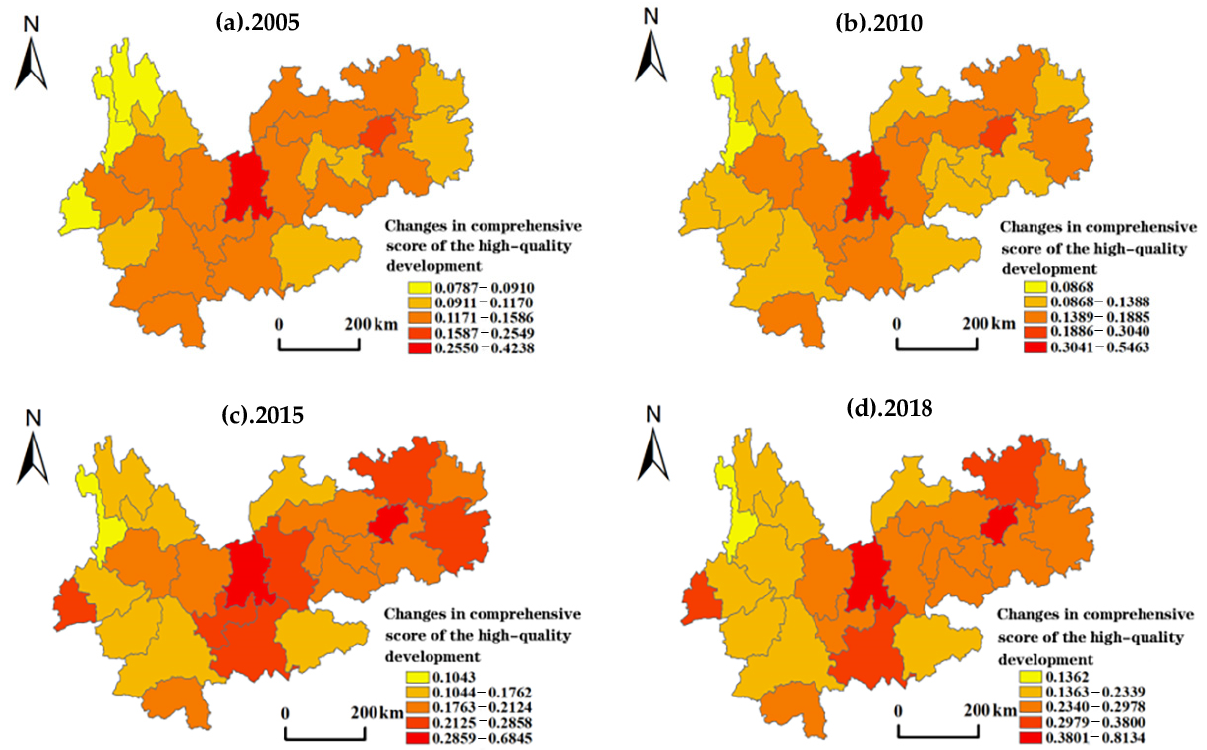
Figure 3. Spatial distribution of the high-quality development level in YGR.